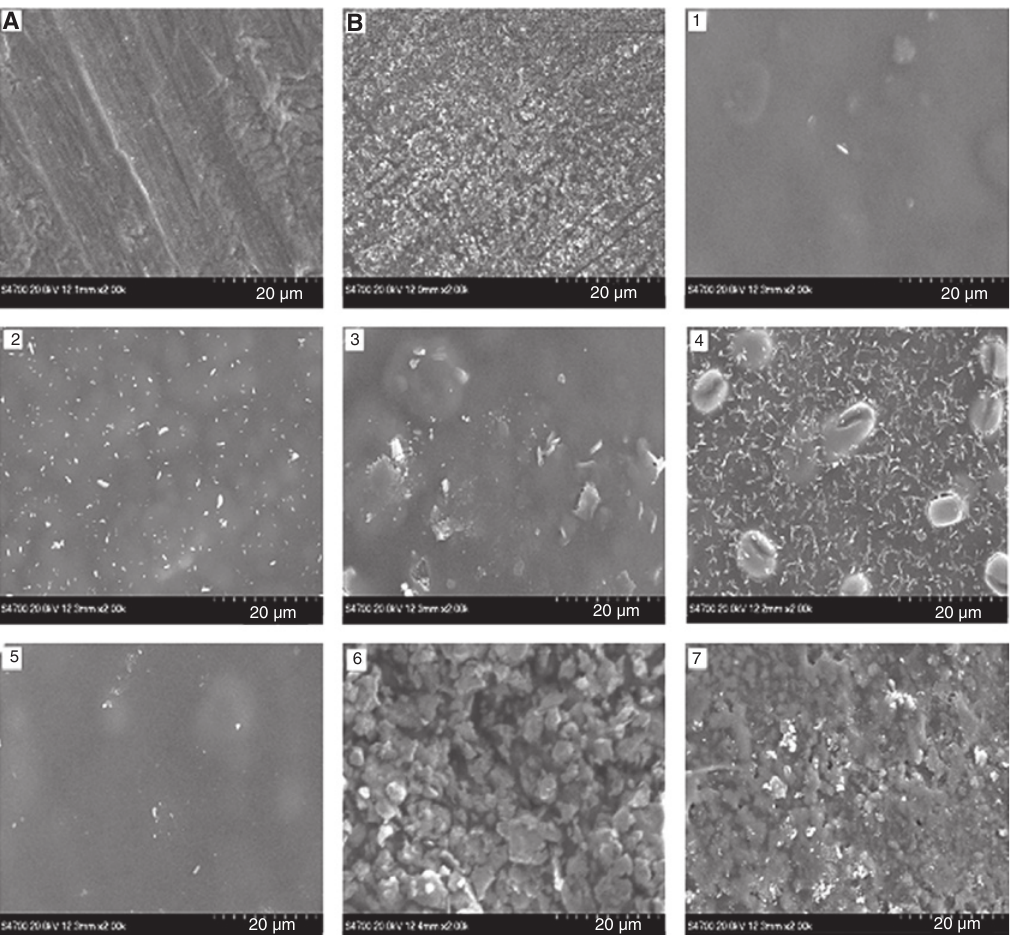
Co /Al O /FeCrAl catalysts, (1) x = 1, x 1- x 2 3